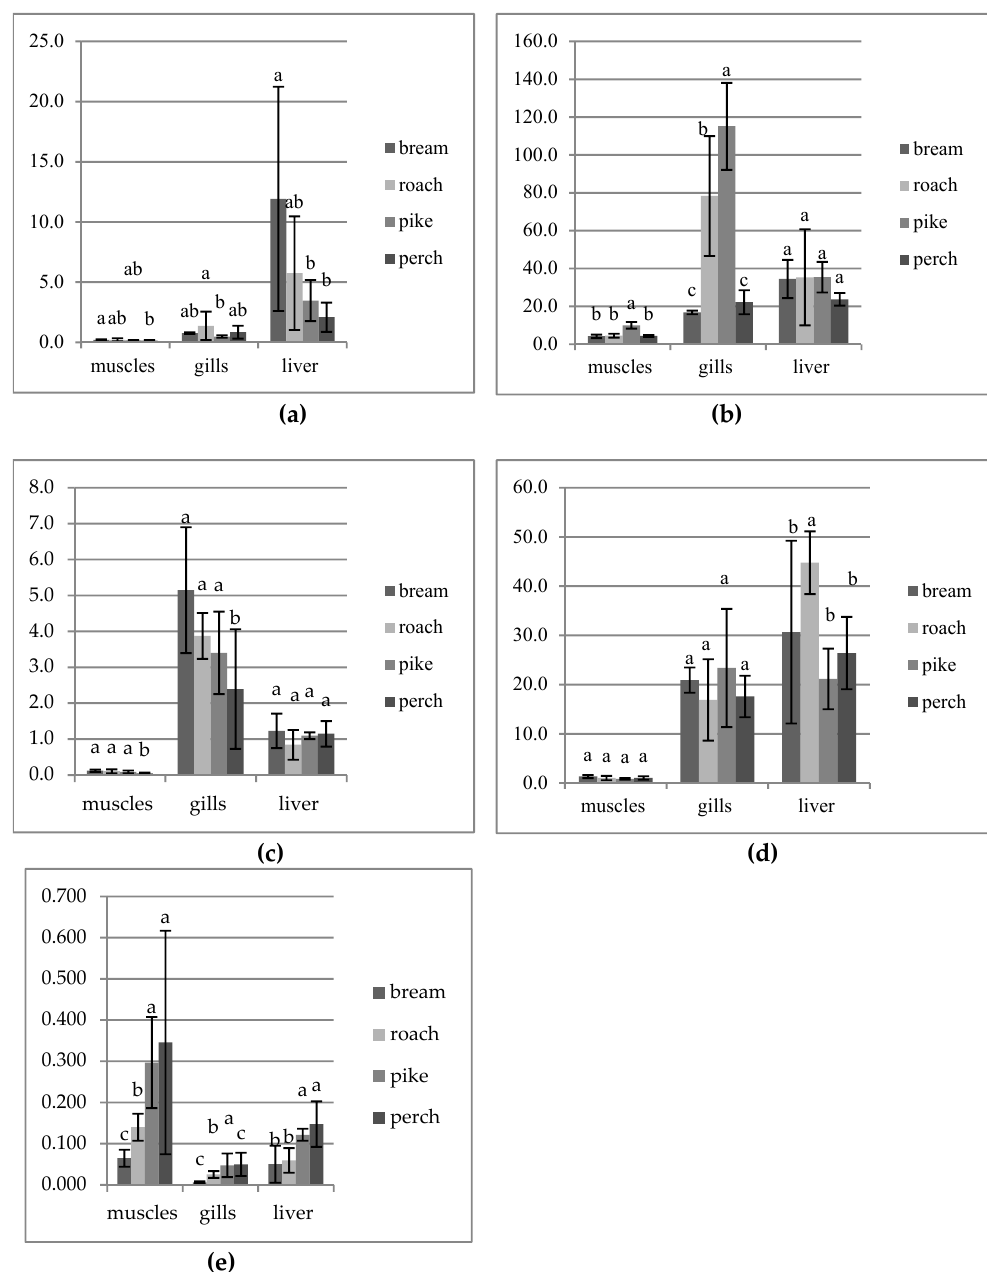
Figure 2. Differences (mean ± SD) in the content of heavy metals in the same organs of fish ( a ) Cu, ( b ) Zn, ( c ) Mn, ( d ) Fe and ( e ) Hg; a, b, c—significant differences between the same organs of the different species ( p ≤ 0.05). The same letter indicates the absence of significant differences ( p > 0.05). Generally, the concentration of 18 elements, including Hg, Fe, Cu, Mn and Zn significantly differed between species such as sichel ( Pelecus cultratus ), ruffe ( Gymnocephalus cernua ) and